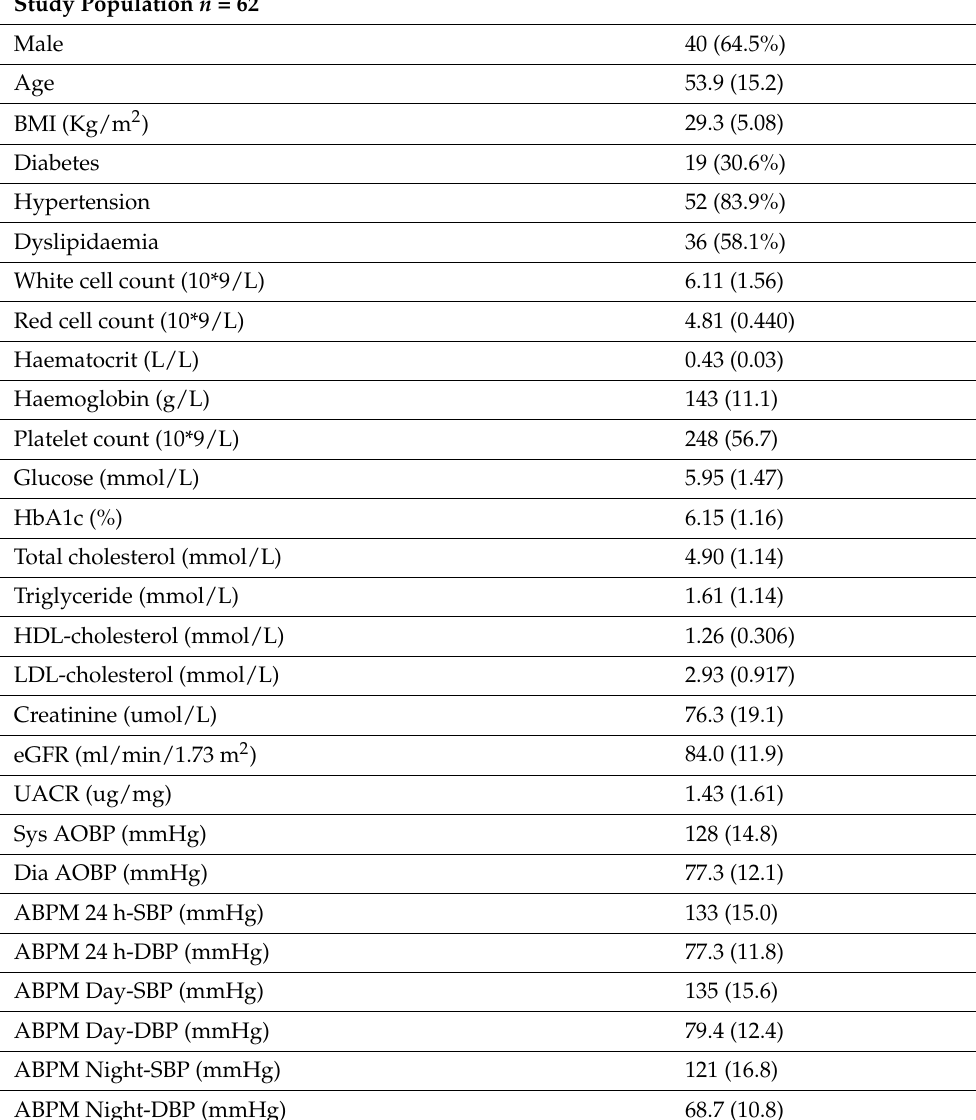
Table 1. Baseline characteristics of the analysed patient